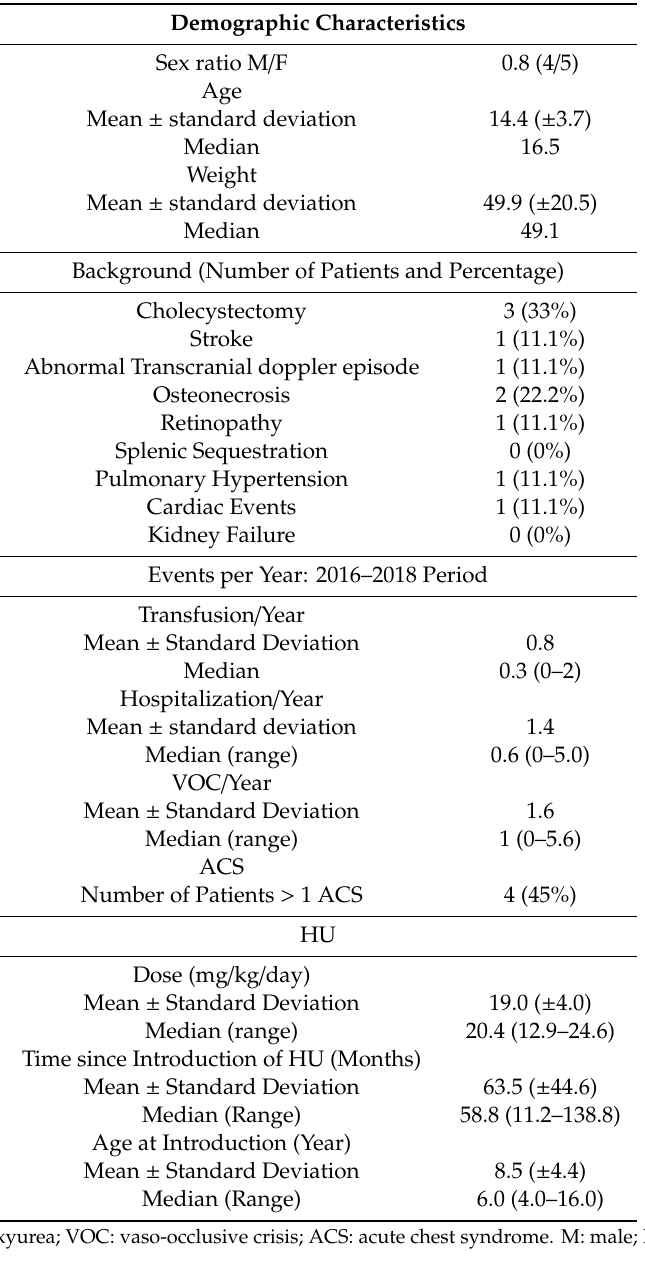
Table 1. Patient